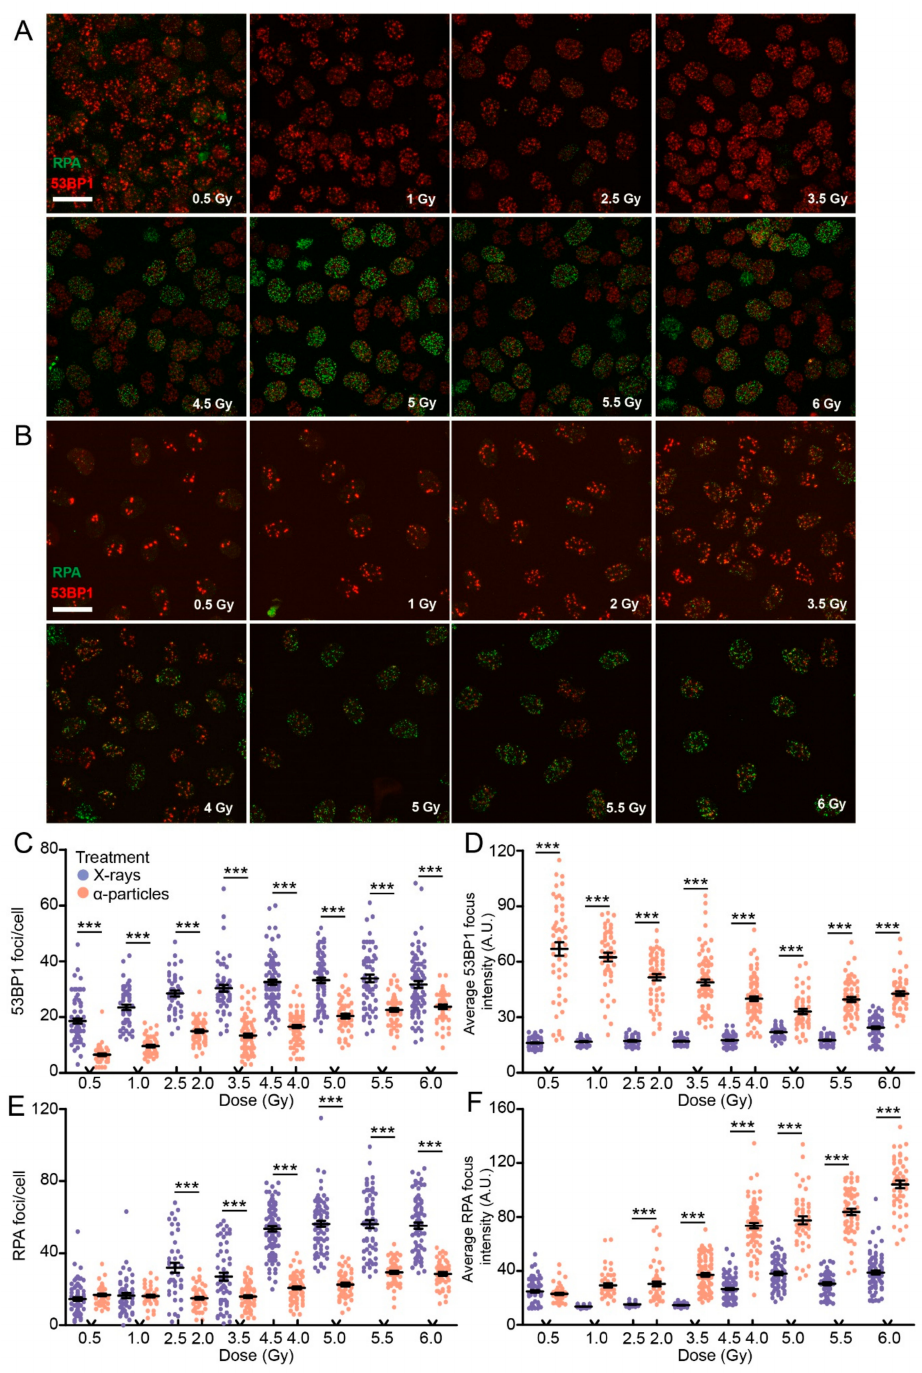
Figure 4. Focus kinetics of 53BP1 and RPA are dose- and radiation type-dependent. Overview of 53BP1 and RPA staining after X-ray ( A ) and α -particle ( B ) irradiation using a dose gradient. Cells were fixed 1 h after irradiation. Quantification of 53BP1 foci per EdU-positive cell ( C ) and intensity ( D ). Quantification of RPA foci per EdU-positive cell ( E ) and intensity ( F ). More than 100 EdU-positive cells were analyzed in two independent experiments. Data points in the plot indicate single nuclei treated with X-ray irradiation (purple) or α -particles (orange). Error bars indicate SEM. Black bars indicate the mean. The statistical di ff erences are indicated by asterisks (***, p < 0.001) and determined by ANOVA followed by Tukey’s multiple comparison